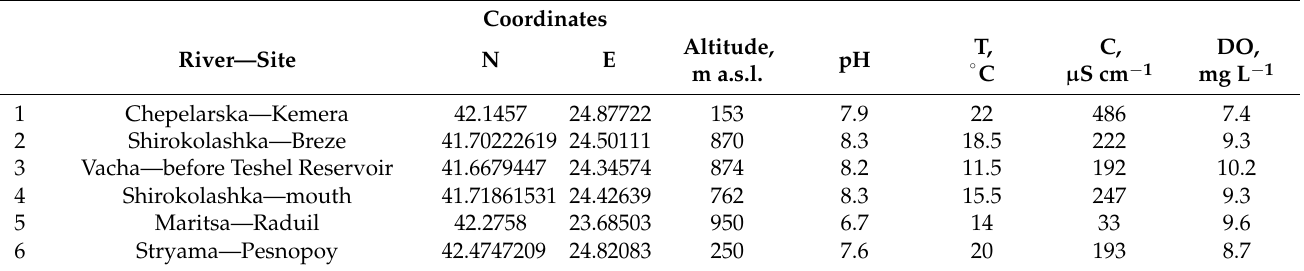
Table 1. List of the studied river sites, coordinates (WGS84), altitude, and basic physicochemical parameters. Legend: T—temperature; C—conductivity; DO—dissolved